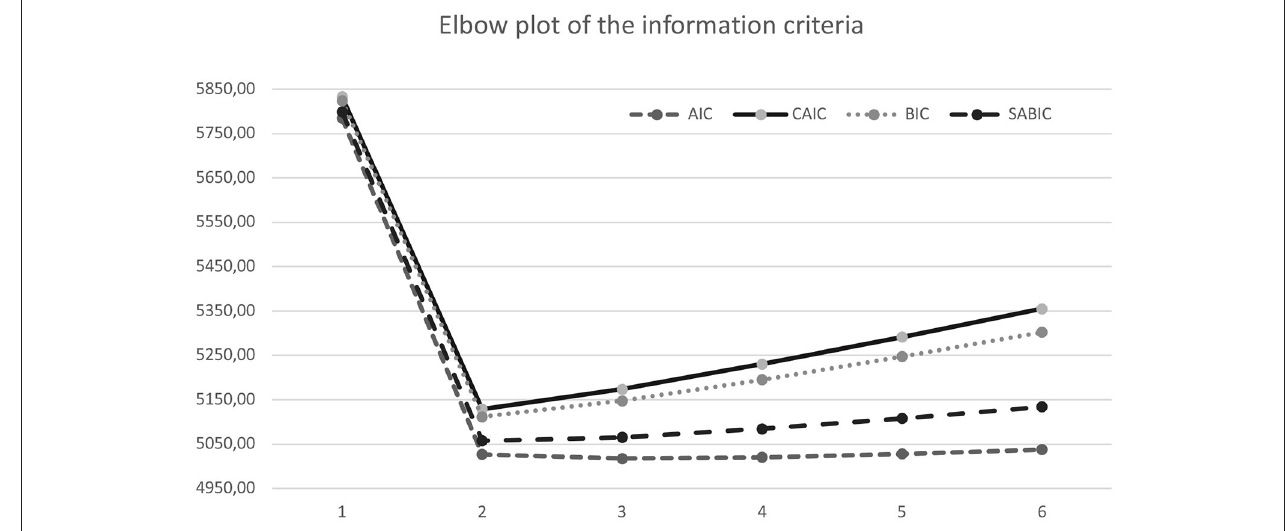
FIGURE 1 | Elbow plot of the information criteria.